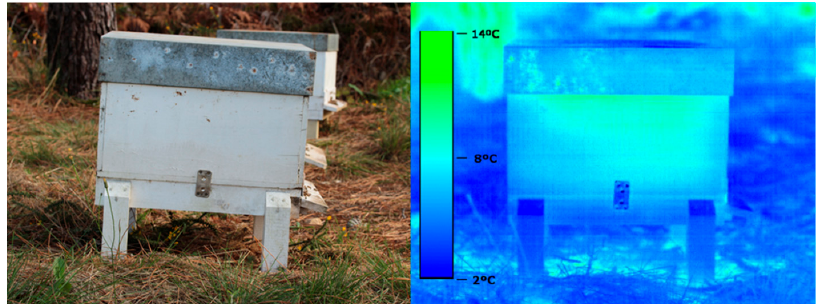
Figure 1. Example of the images generated by the different imaging sensors used. ( Left ) Red Green Blue (RGB) image. ( Right ) Example of the thermographic image acquired, with thermal values represented using a color map: Dark blue is given to the lowest values (in this case, 2 °C), going to light blue and green for the highest temperature values (14 °C in this case study).